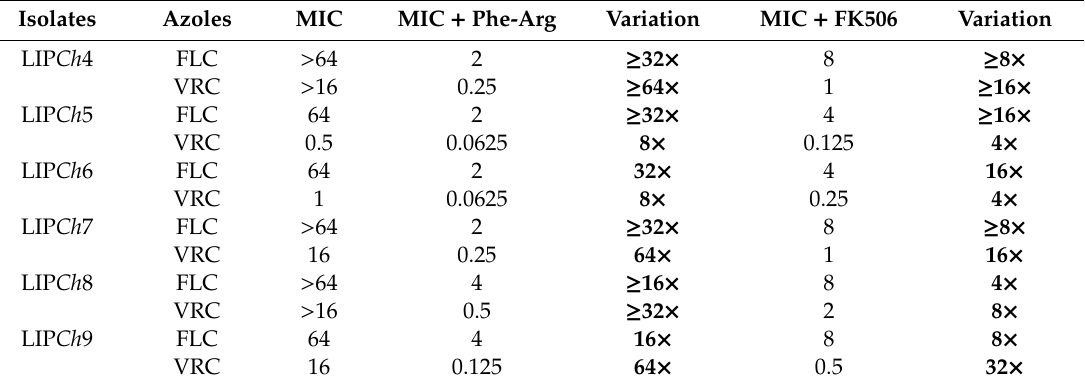
Table 3. E ff ect of the inhibition of e ffl ux pumps (EPIs) on the azole susceptibility in clinical isolates of the C. haemulonii species